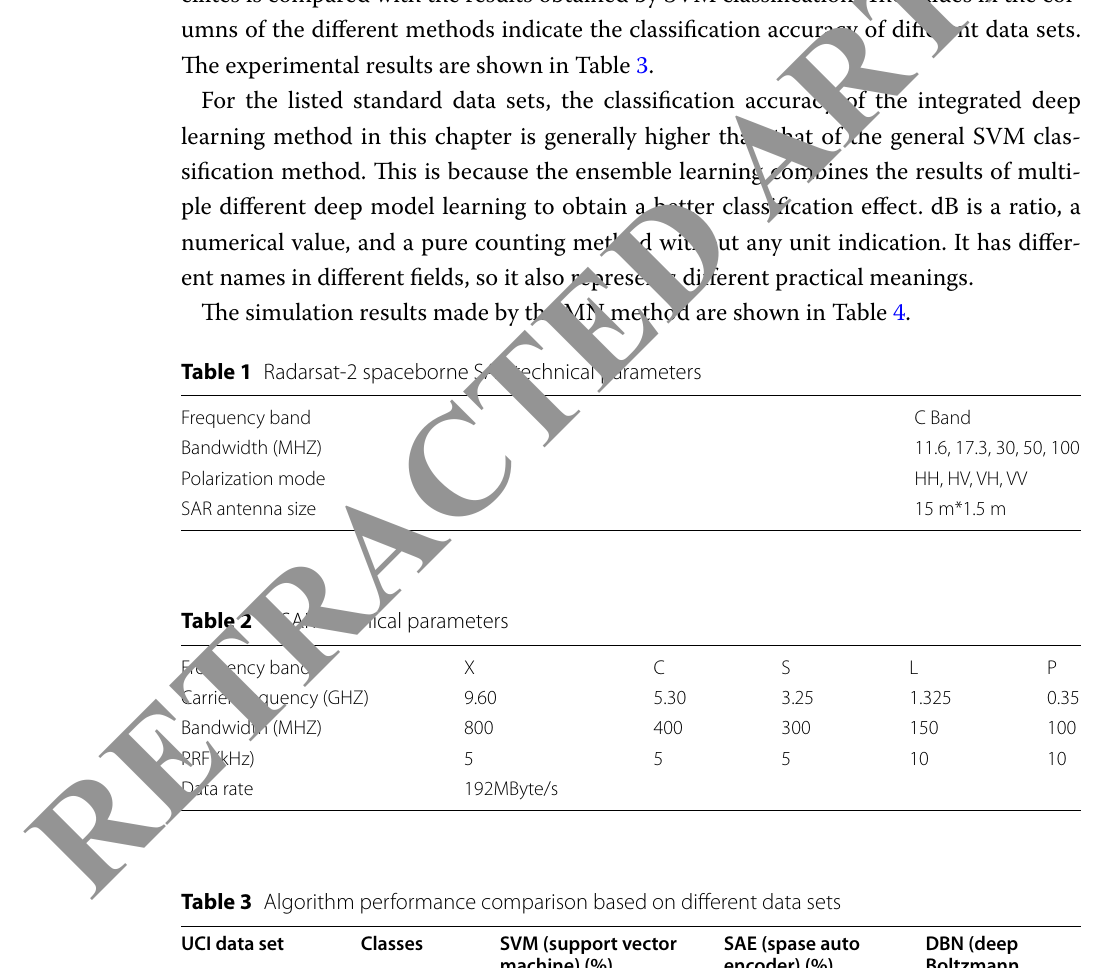
Table 1 Radarsat-2 spaceborne SAR technical parameters Frequency band